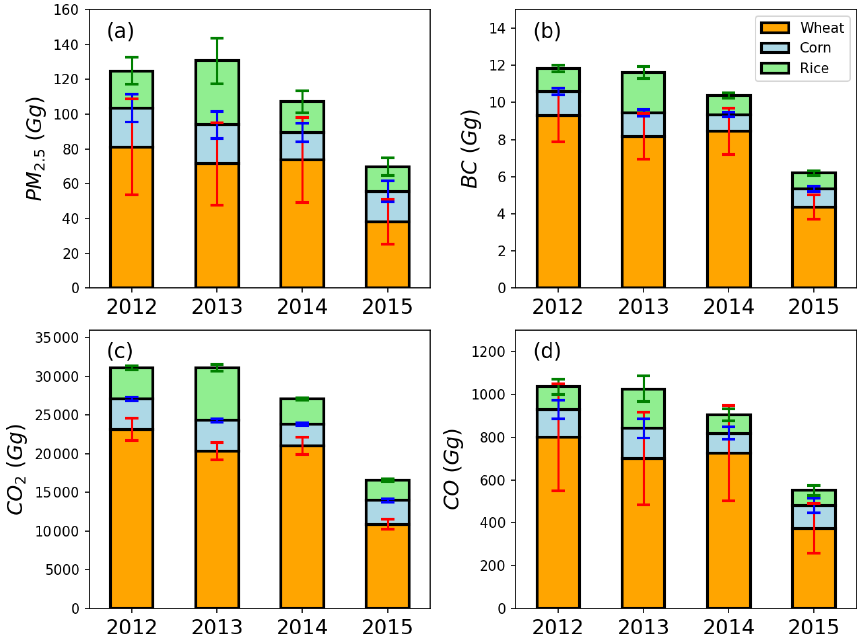
Figure 8. Annual total PM 2 . 5 , BC, CO 2 , and CO emissions for eastern China for the three main crop residue burning types (wheat, corn, rice) calculated for 2012–2015 using the VIIRS-IM/Him-based emissions inventory developed herein. Coloured error bars indicate 1 standard deviation.